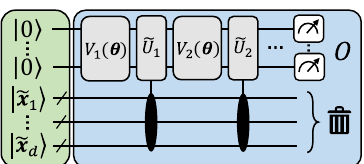
dataset D , the implicit model f * α , D minimizing the training loss associated with D outperforms any explicit minimizer f * θ from the same Reproducing Kernel Hilbert Space (RKHS) with respect to this same training loss. However, depending on the featureencoding ρ ( ⋅ )andthedatadistribution,arestricteddataset D maycausethe implicit minimizer f * α , D to severely over fi t on the dataset and have dramatically worse generalization performance than f * θ .